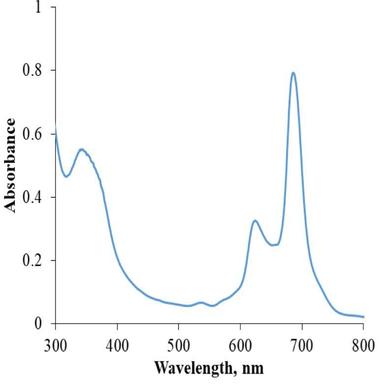
UV–Vis spectrum of the synthesized novel LuPc2 in THF (1.4 × 10− 5 mol dm− 3 ).